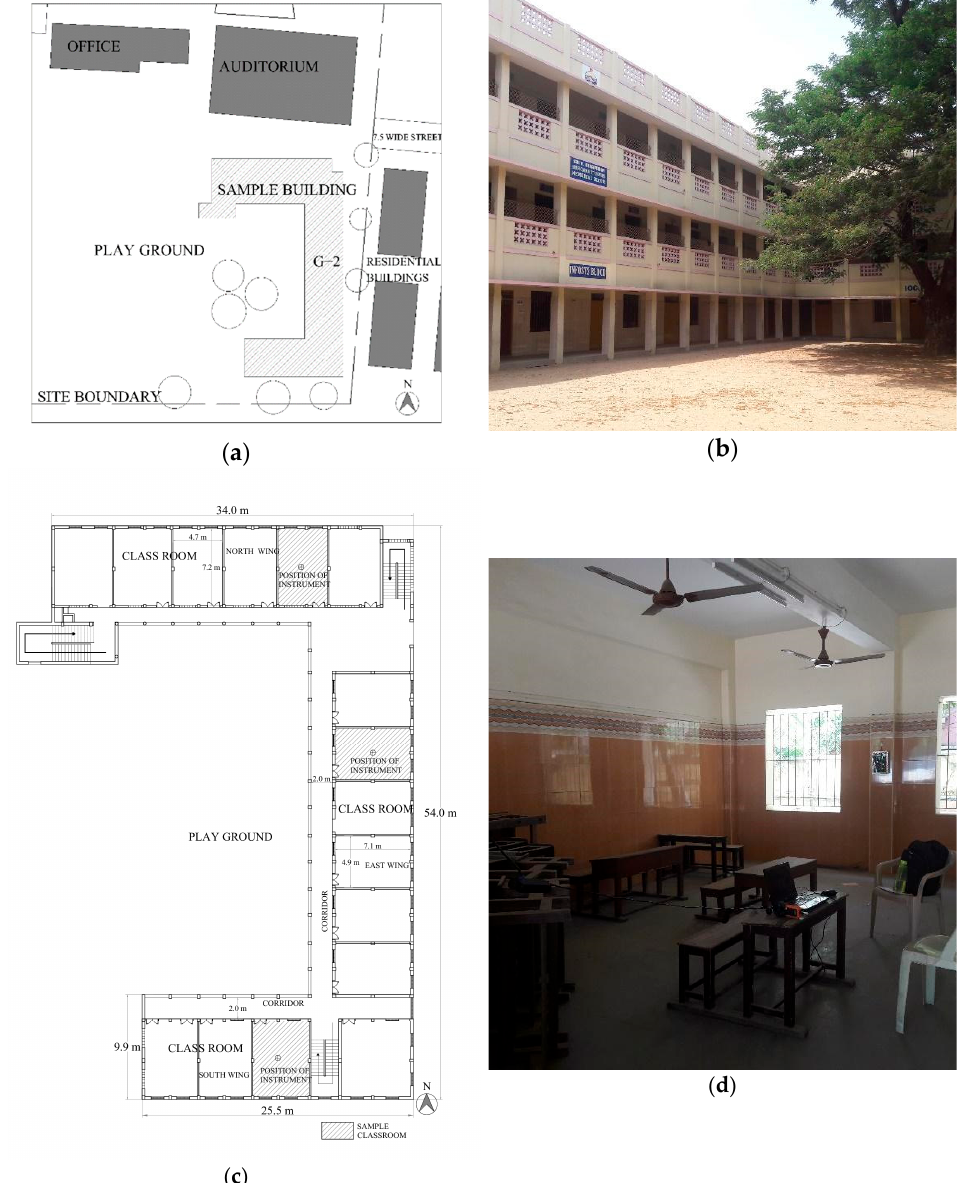
Figure 1. Plan and view of the surveyed reference school building. ( a ) Site plan; ( b ) Courtyard view of the school; ( c ) Second-floor plan with the instrument position in the classroom; ( d ) Classroom view with the instrument.